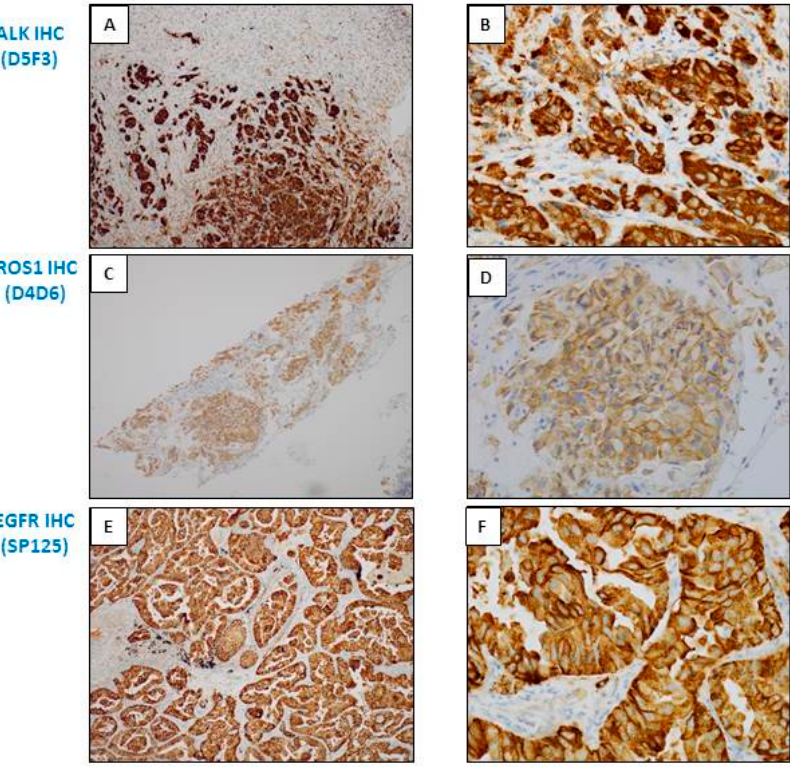
Figure 2. Cont . Figure 2.